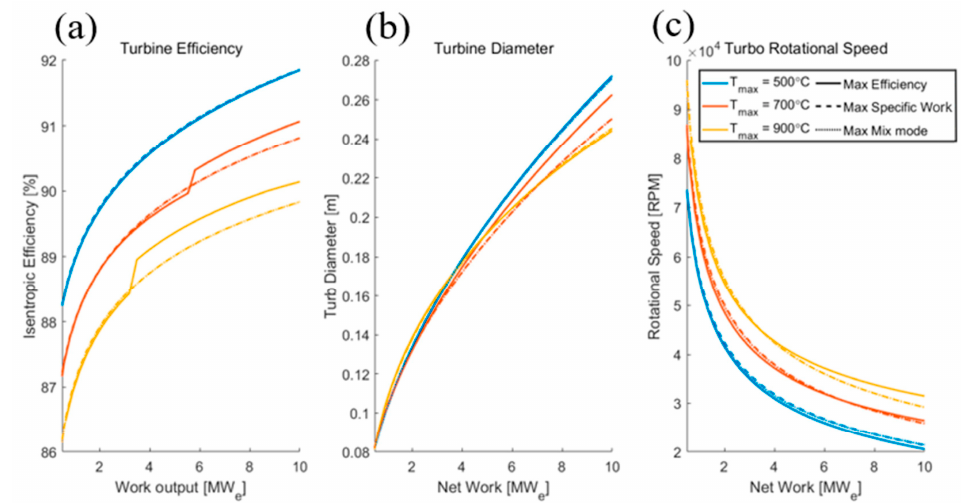
Figure 25. ( a ) Turbine isentropic efficiency, ( b ) Turbine rotor diameter, and ( c ) Rotational speed of S-CO 2 Brayton cycle.